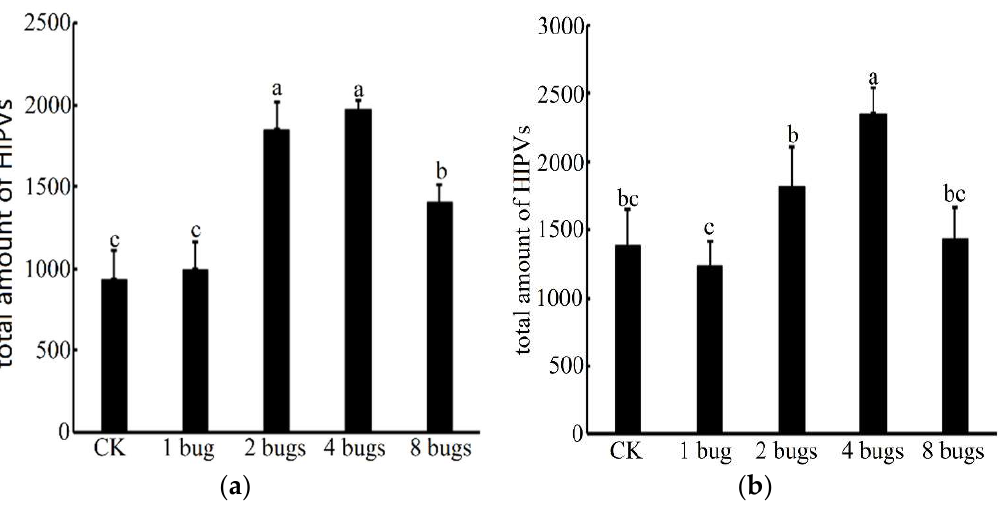
Figure 2. Total amount of HIPVs released from cotton plants and showed by Mean ± SE. Amounts with different letters were significantly different at the 5% level by Tukey’s HSD test. ( a ) Released at the period from 17:00 p.m. to 21:00 p.m.; ( b ) Released at the period from 10:00 a.m. to 14:00 p.m.